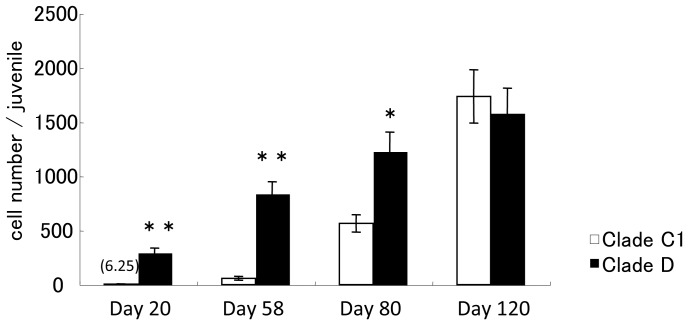
Number of symbiotic algal cells within clades C1 or D in juvenile polyps during the first 4 months after inoculation.Four juveniles were used to enumerate endosymbiont cells in each treatment and period. Values are means ± S.E. of the number of Symbiodinium algal cells per juvenile. The number above the bars for clade C1 at the day 20 indicates actual cell number. Asterisks indicate statistically significant differences resulting from t-tests: * P<0.05, ** P<0.01.